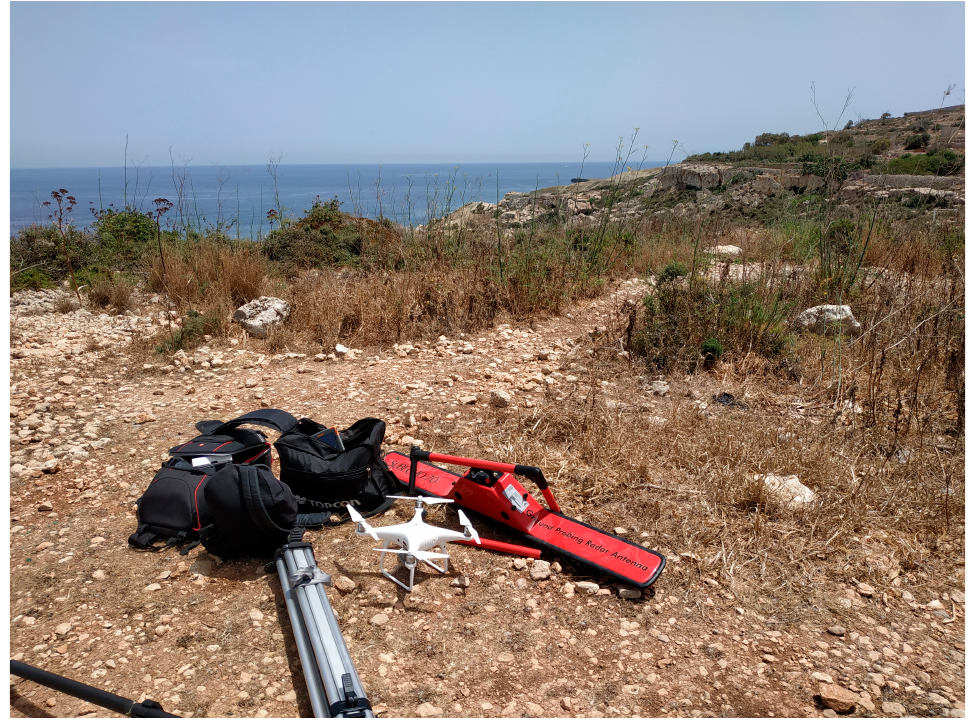
Figure 3. Photo acquired during the georadar survey. The photo shows the tripod and rod of the Differential GNSS, the Phantom 4 Pro UAV used for photogrammetric survey and the Cobra Subecho-70 georadar.